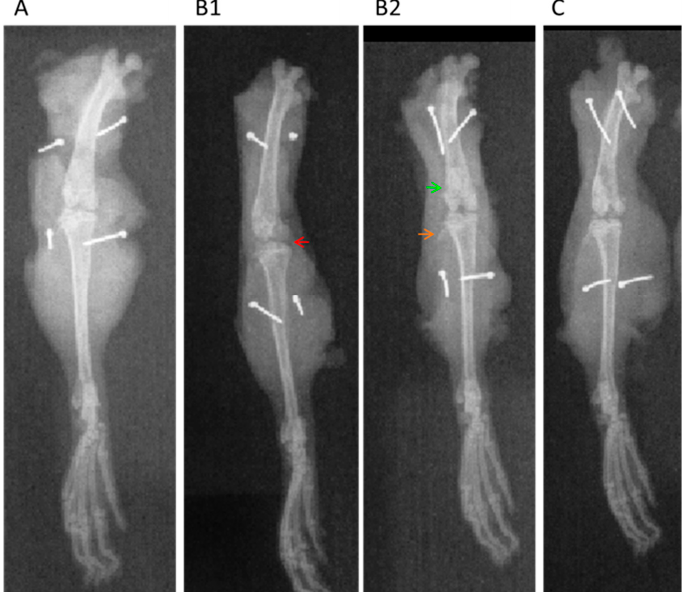
Figure 7. Knee radiographs in the antero-posterior projection. A -RX from the healthy rat paw (CLEAN); B1 and B2 -RX from the rat paw with experimental model of MIA-induced osteoarthritis– saline group; C -RX, A. chica extract 450 mg/kg treated group. This analysis was performed with the knees collected on day 29 after OA induction. Arrowhead: red—indicating a remarkable narrowing of the joint space and deformity in the bone contour; green—subchondral sclerosis; orange—large osteophytes.